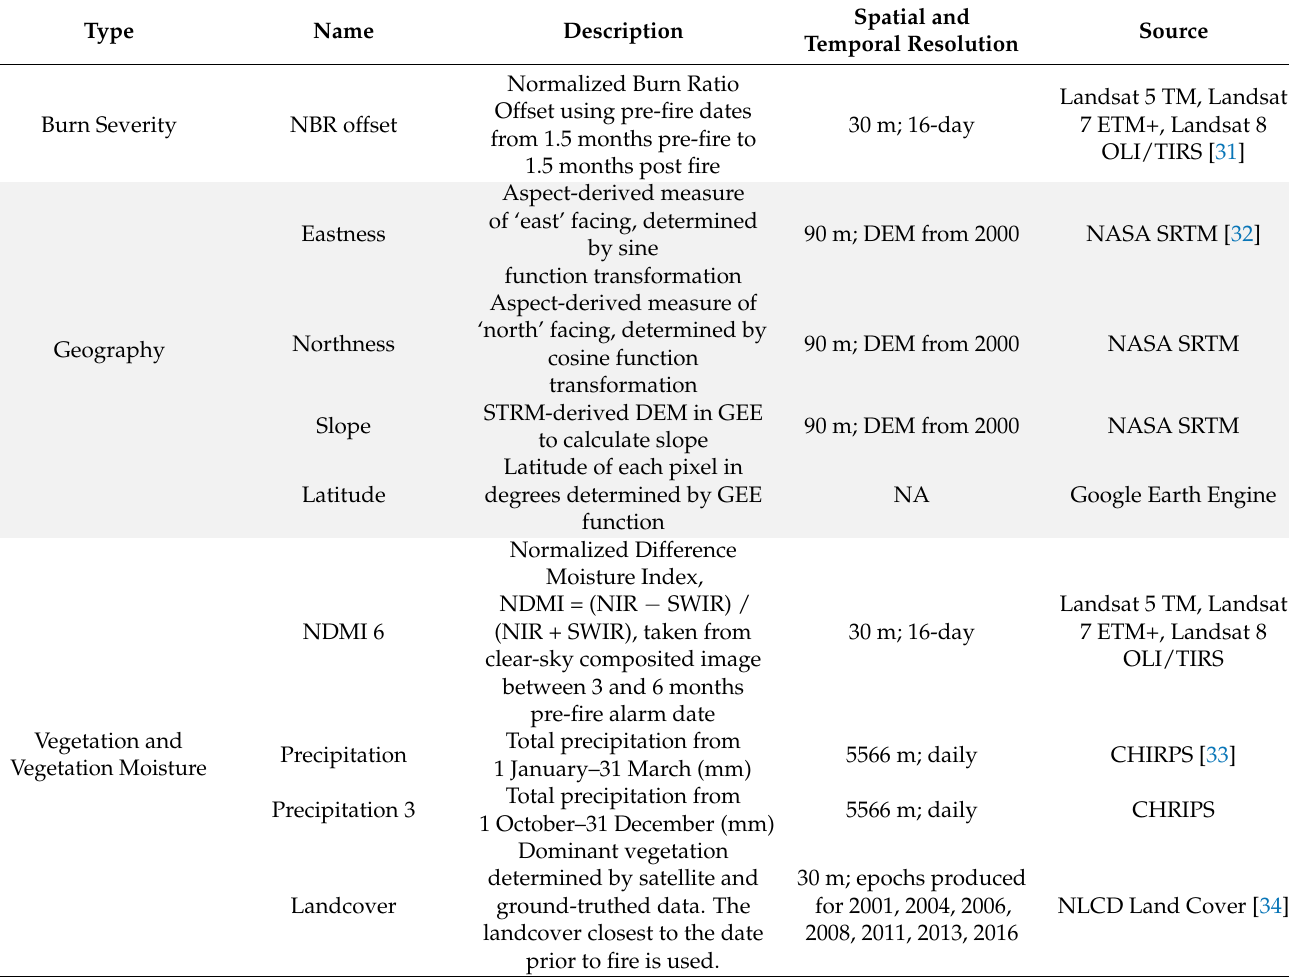
Table 1. The variables and their origin used for the PSM and regression analysis. PSM used all the listed variables except for the Burn Severity, which was only used in the regression